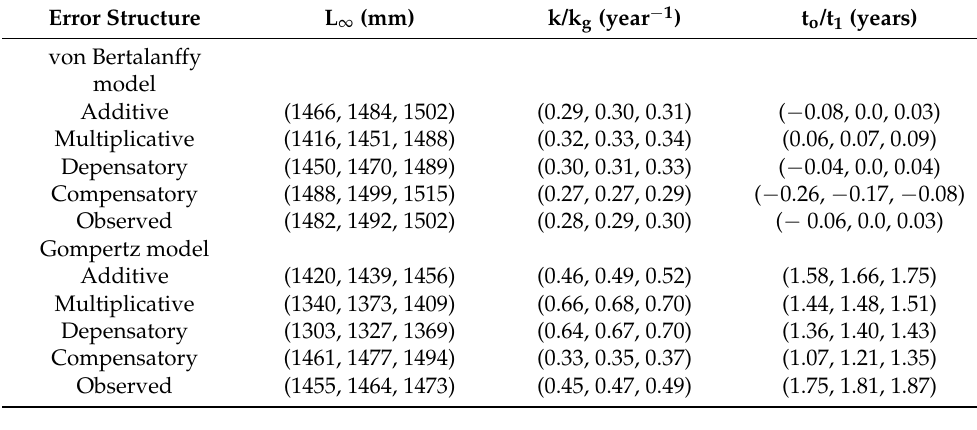
Table 2. Mean and 95% confidence intervals for the parameters using five error structures for the two growth models tested. t 0 corresponds to the age at zero length of von Bertalanffy and t 1 to the inflexion point of the Gompertz model. L ∞ is the asymptotic total length. For the von Bertalanffy model, k is the growth or Brody coefficient. For the Gompertz model, k g is the instantaneous growth rate at age t 1 .